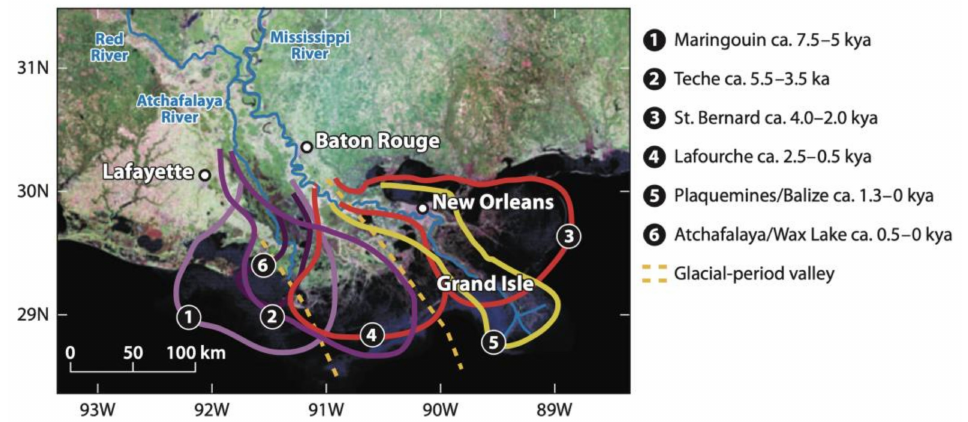
Figure 2. Holocene deltas of the lower Mississippi River (modified from